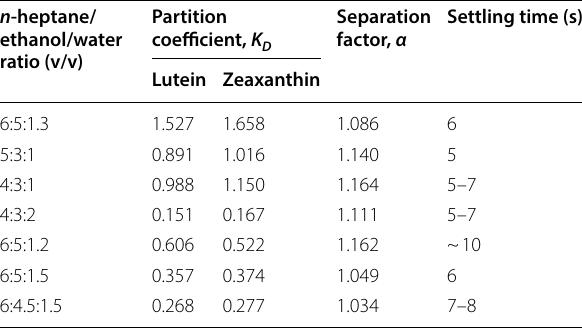
Table 6 Partition coefficients and separation factors of lutein and zeaxanthin from variation on a solvent system of n